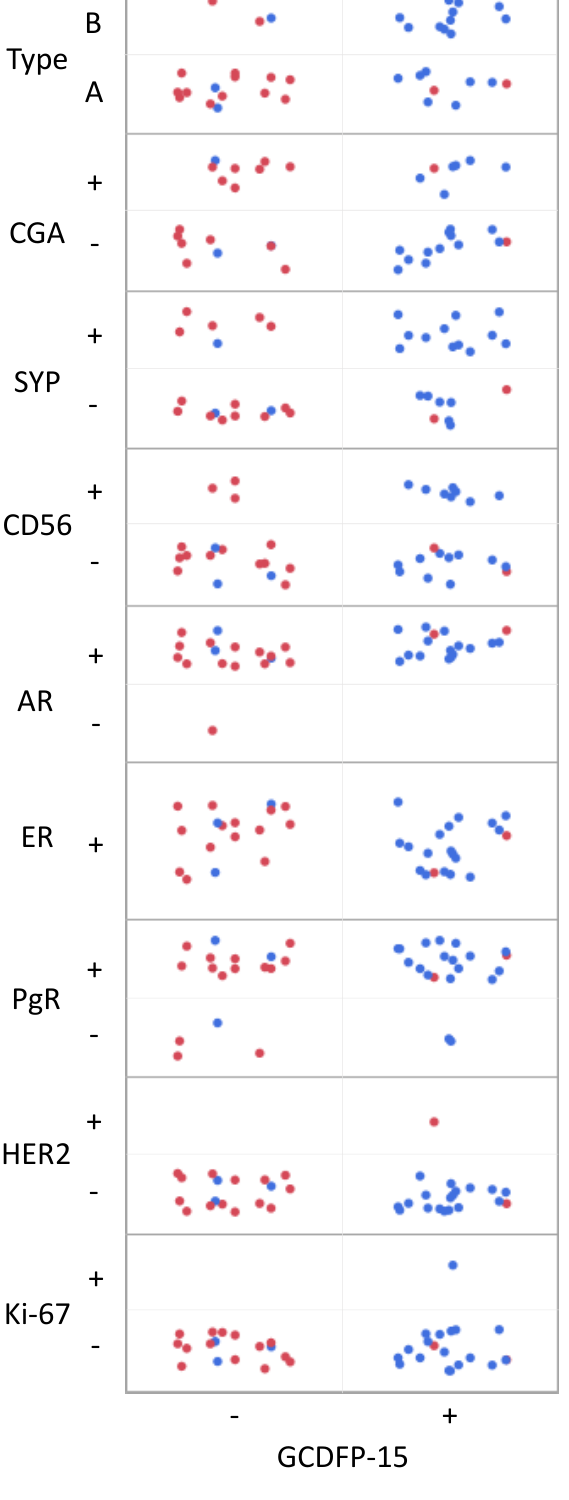
Figure 3. The relationships between GCDFP-15 expression and type of mucinous carcinoma or the expression of other immunohistochemical markers considering age (older patients in blue and younger patients in red). AR: androgen receptor; CGA: chromogranin A; ER: estrogen receptor; GCDFP-15: gross cystic disease fluid protein-15; HER2: human epidermal growth receptor 2; PgR: progesterone receptor; SYP: synaptophysin.